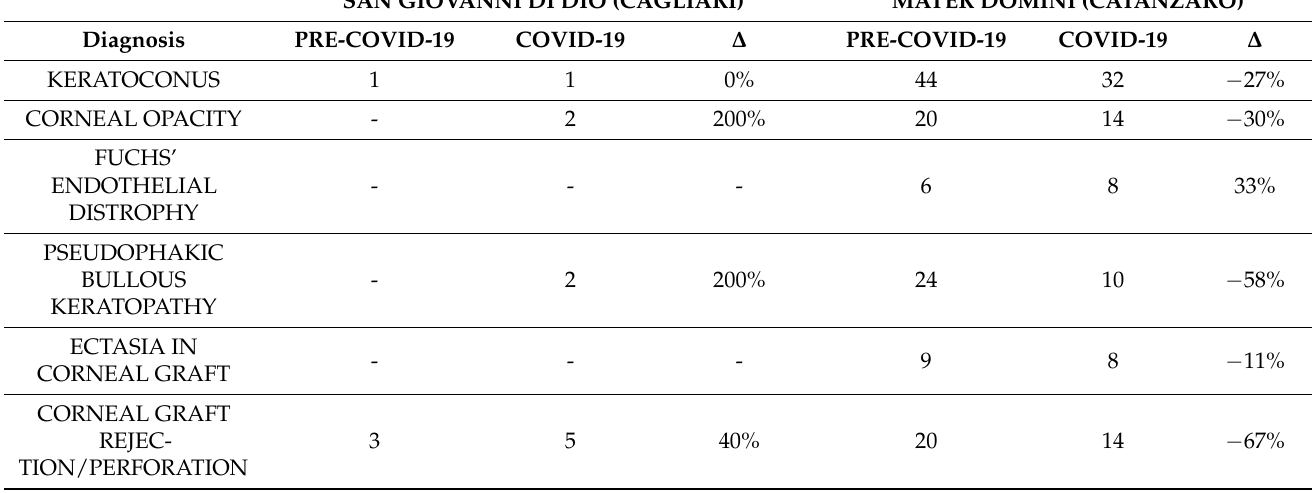
Table 2. Comparison of different diagnoses of surgically treated anterior segment diseases at San Giovanni di Dio (SGD), University of Cagliari, and Mater Domini, University Magna Græcia of Catanzaro (UMG).